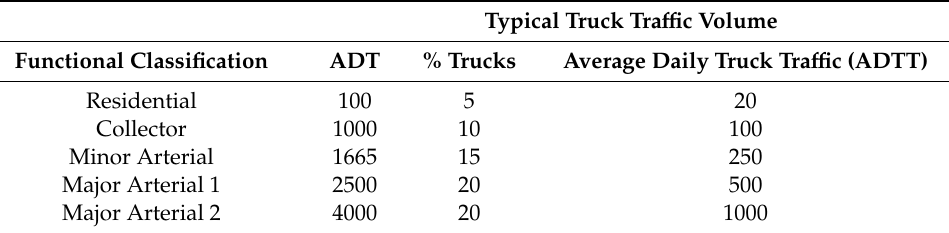
Table 3. Typical average daily truck traffic for five functional classifications.